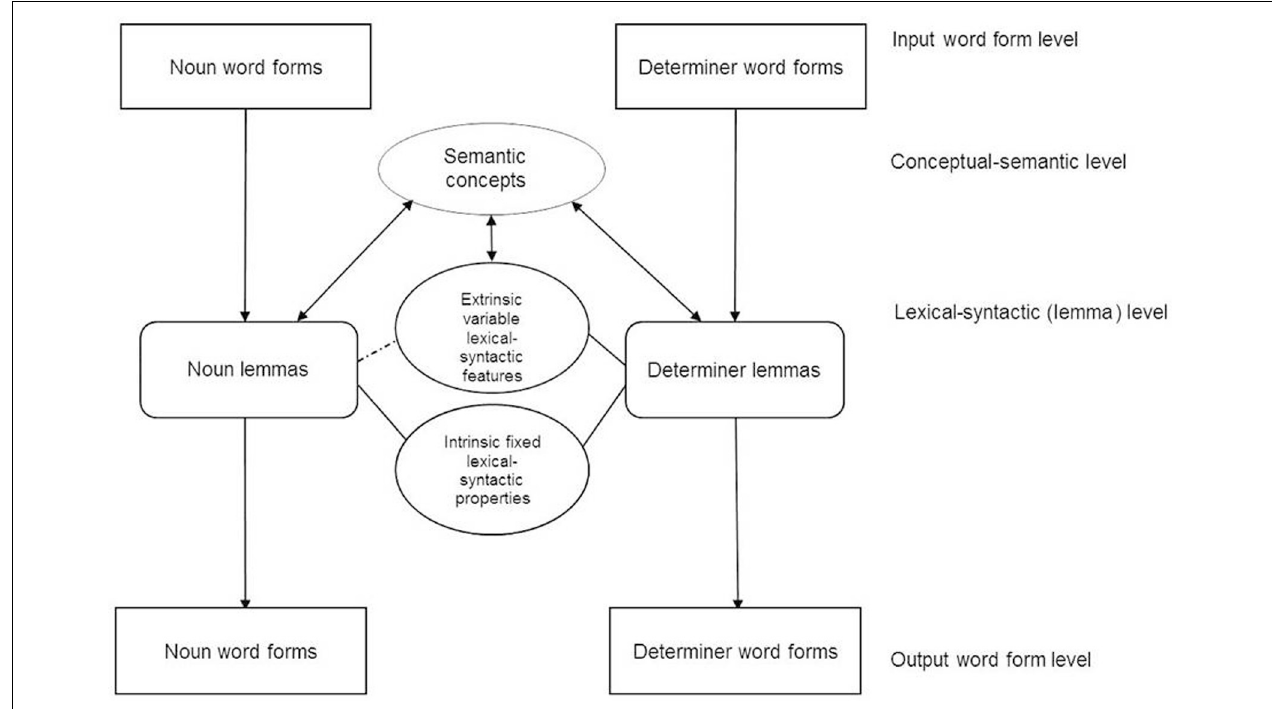
FIGURE 10 | General illustration of the different levels involved in language processing and production of noun phrases derived from Levelt et al.’s (1999) theory. Extrinsic variable lexical-syntactic features